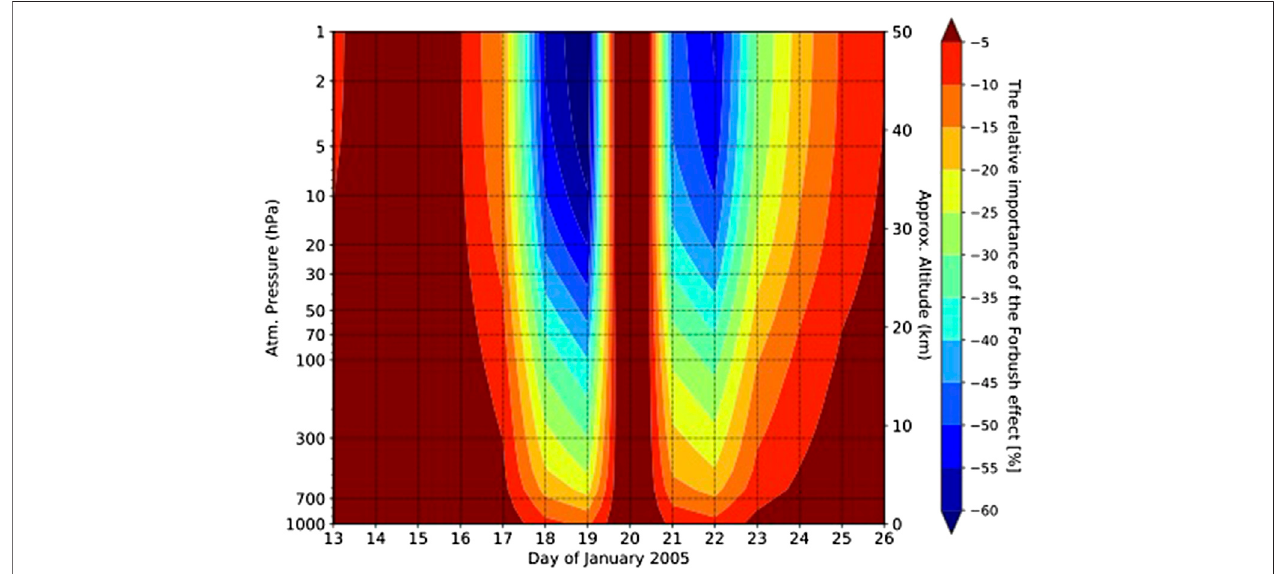
FIGURE 1 | The GCR induced ionization rates (IR) change with respect to the January 1, 2005 are presented for the polar atmosphere (covering 90N-75N).